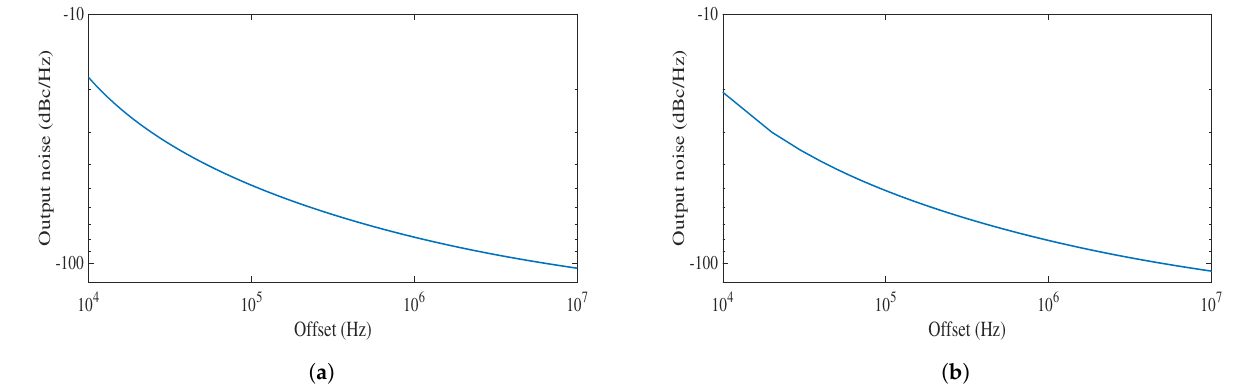
Figure 9. Phase noise performance of the ( a ) DAC-based DCO, ( b ) Controller-based DCO.